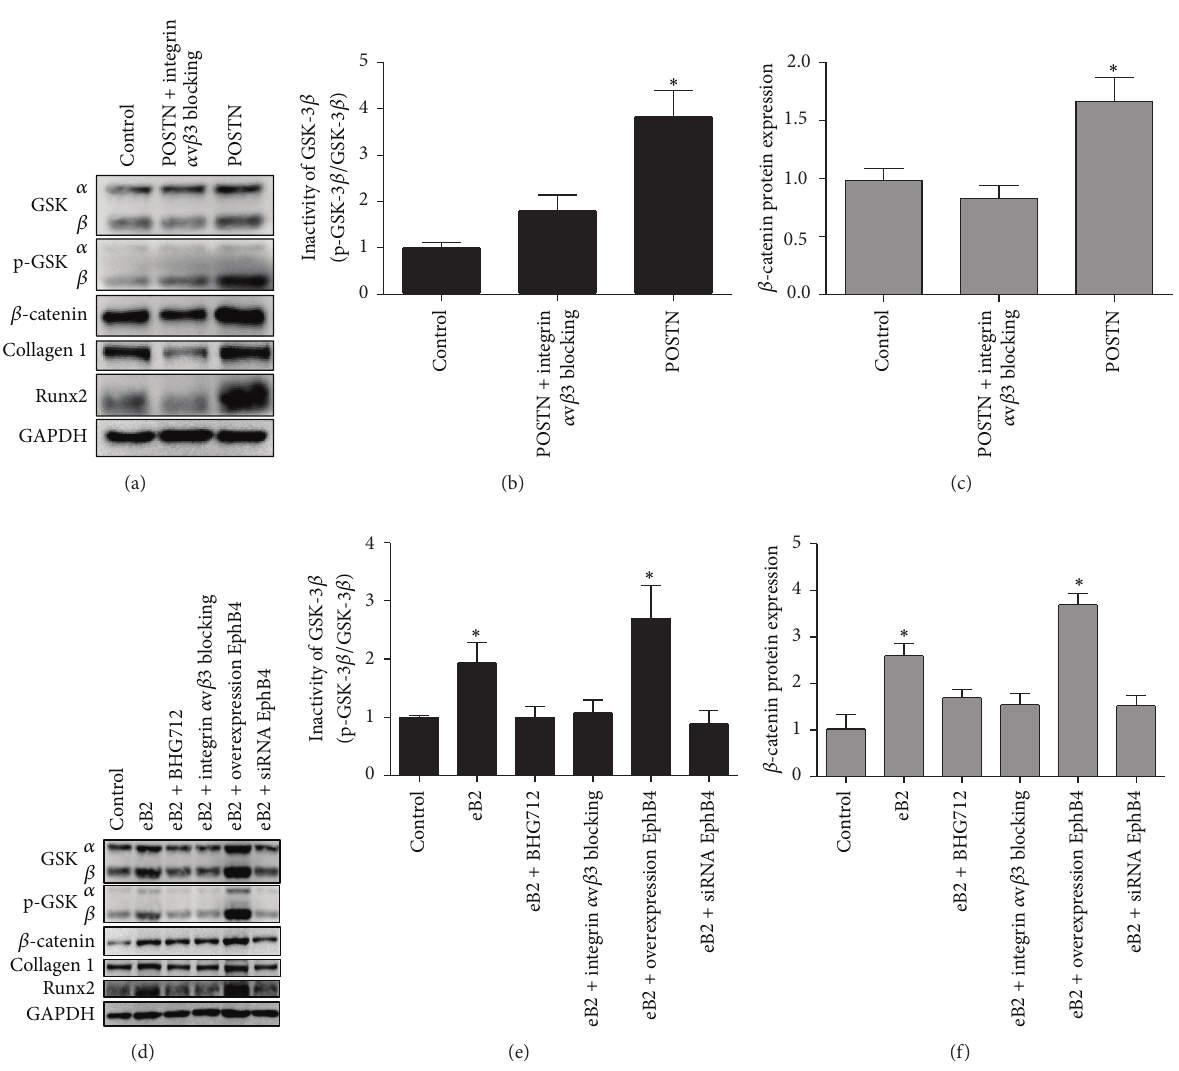
Figure 5: Osteogenic differentiation mechanism of the EphB4 pathway. (a) POSTN treatment and integrin 𝛼 v 𝛽 3 blocking were applied to MSCs for 3 days, and cell lysates (20 𝜇 g each) were subjected to western blotting. Untreated MSCs were used as the control. (b, c) The levels of inactive GSK (p-GSK-3 𝛽 -Ser9/GSK-3 𝛽 ) and 𝛽 -catenin were quantified using ImageJ2x and expressed as a fold-change over that of the control. Bars represent means ± SD from 3 biological replicates; ∗ 𝑃 < 0.05 . (d) Integrin 𝛼 v 𝛽 3 blocking, ephrinB2-FC treatment, and BHG712 treatment were applied for 3 days, and cell lysates (20 𝜇 g each) were extracted for western blotting. Again, untreated MSCs were used as the control. (e, f) The levels of inactive GSK (p-GSK-3 𝛽 -Ser9/GSK-3 𝛽 ) and 𝛽 -catenin were quantified using ImageJ2x and expressed as a fold-change over that of the control. Bars represent means ± SD from 3 biological replicates; ∗ 𝑃 < 0.05